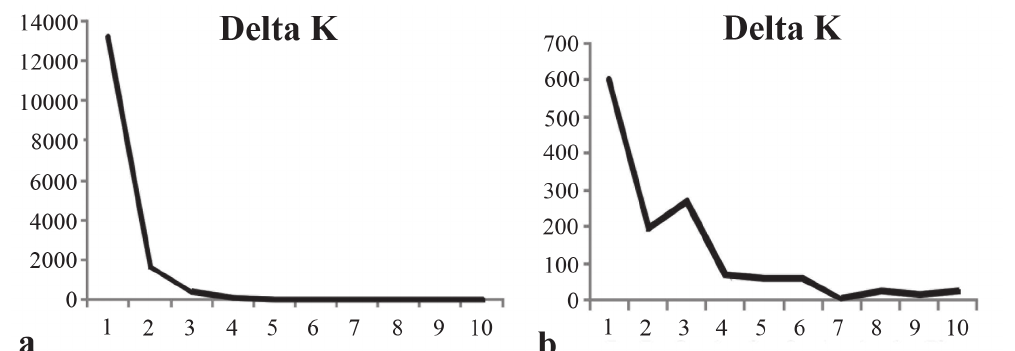
Fig. 2. Mean values of Ln(P)D of Leporinus elongatus from the fish passage ladders of HEPs Canoas I and Canoas II - Paranapanema River. a = delta K for RAPD markers, and b = delta K for microsatellite